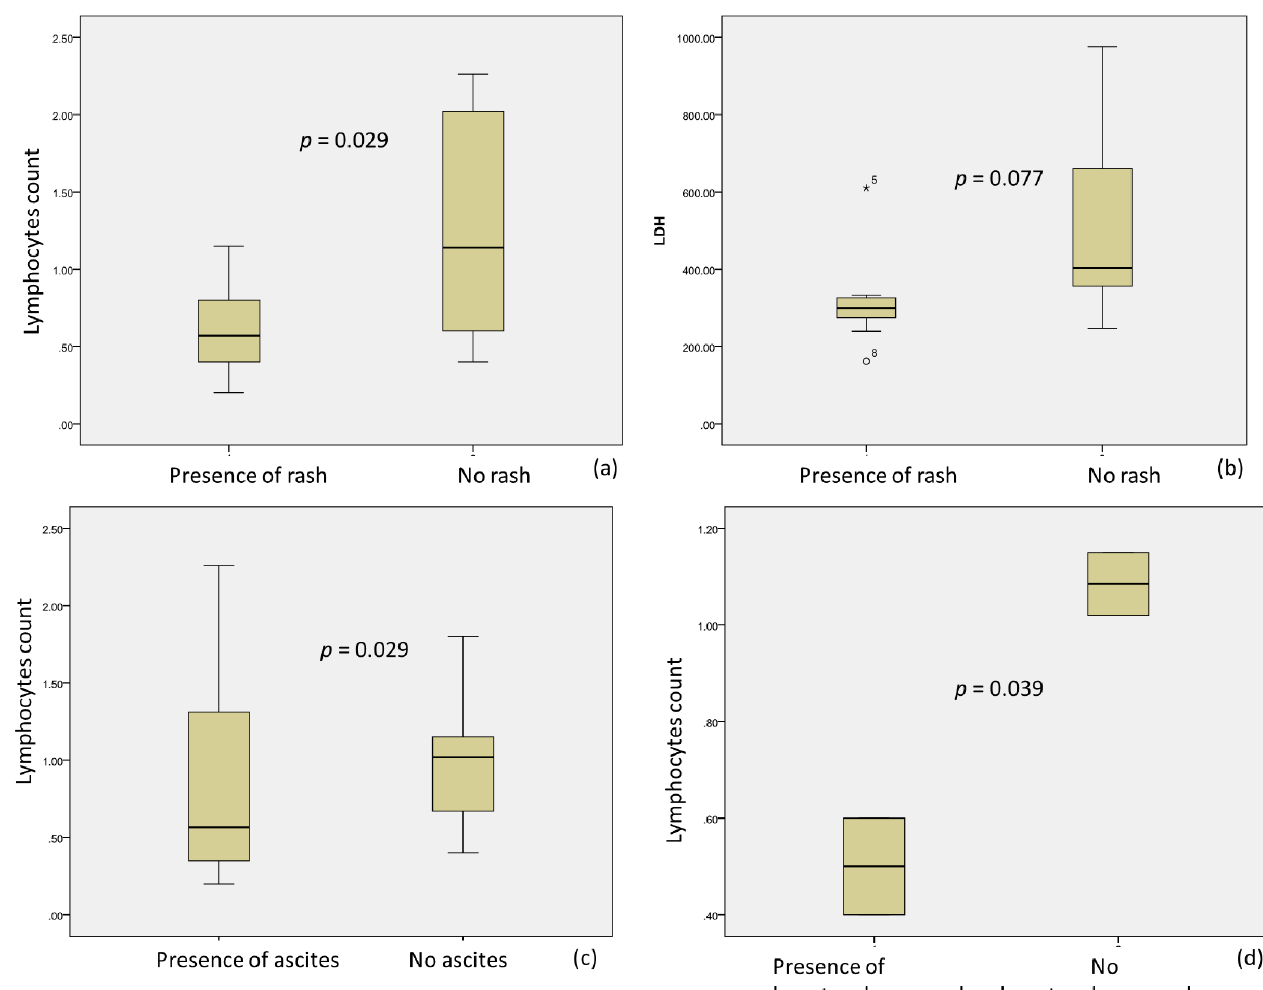
Figure 4. Association of rash with lymphopenia ( a ) and LDH levels ( b ), as well as ascites with lymphopenia ( c ) and hepatosplenomegaly with lymphopenia ( d ). *5 and °8 ( b ) denote outliers.